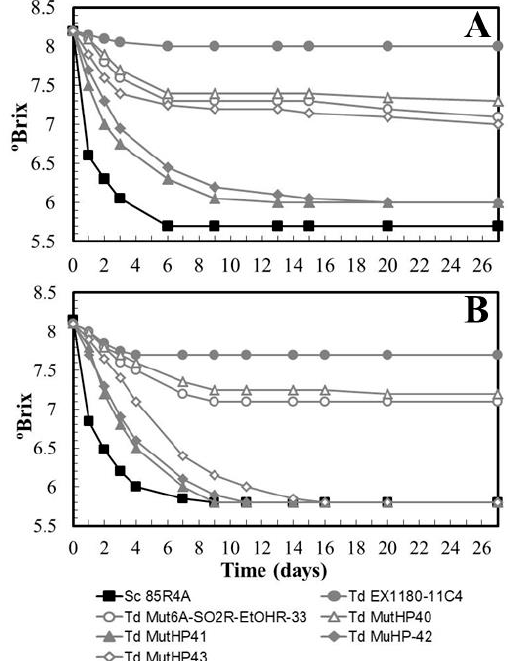
Figure 6. Fermentation kinetics of some T. delbrueckii HP R mutants inoculated in synthetic base wine supplemented with 50 mg/L ( A ) or 30 mg/L SO 2 ( B ). Data are the mean values of three fermentations inoculated with each yeast strain. Standard deviations were less than 8% of the means. The degree of dominance throughout fermentation of each inoculated yeast strain was 100%.